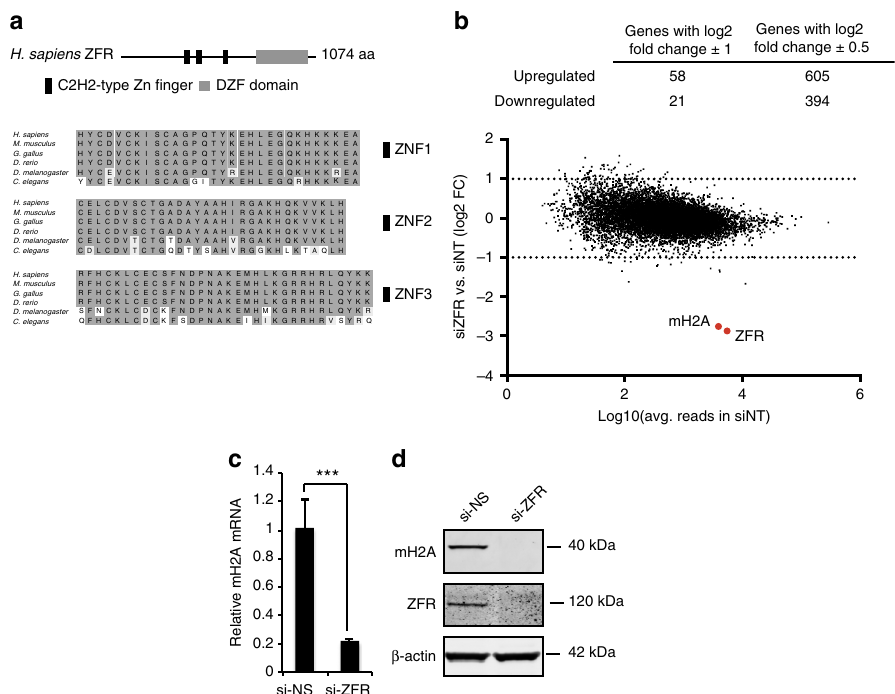
Fig. 1 Evolutionarily conserved ZFR protein is required for macroH2A1 expression. a Schematic of the ZFR protein depicting N-terminal Zn- fi ngers and C- terminal DZF domain (top), and sequence conservation of ZFR Zn- fi ngers in the indicated species (bottom). b RNA-seq analysis of HEK-293TO cells transfected with si-ZFR or si-NS ( n = 3). Top, numbers of genes upregulated or downregulated by ZFR depletion at the indicated thresholds, with adjusted P < 0.05. Bottom, scatter plot of fold change in mRNA abundance vs. number of reads derived from each gene, with mH2A1 and ZFR highlighted in red. c qRT-PCR analysis of mH2A1 in cells treated as in b . Graphs indicate mean ± SD; *** P < 0.001 (two-tailed Student ’ s t-test). d Immunoblot analysis of ZFR and mH2A1 in cells transfected with si-ZFR or si-NS as in b . β -actin was used as a loading control. Approximate MW based on size markers is